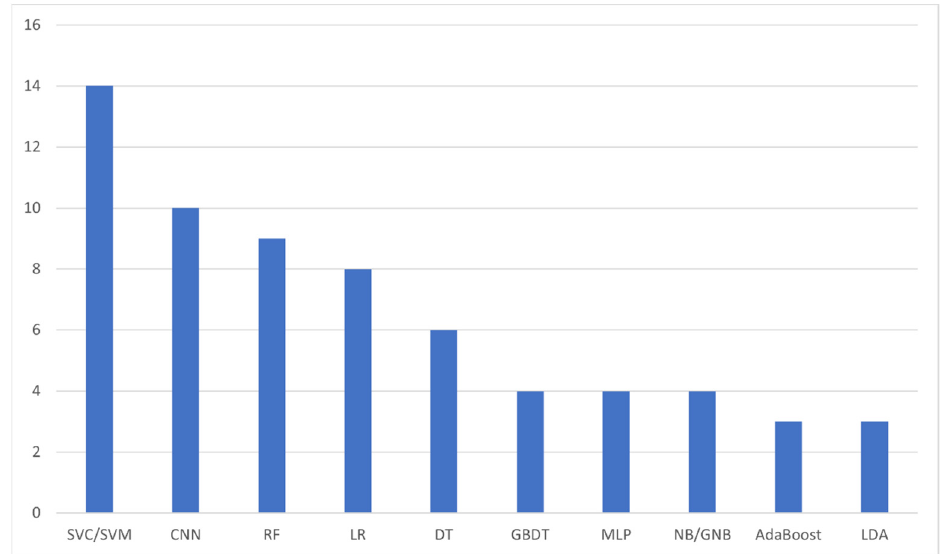
Figure 6. The most frequently appearing artificial intelligence algorithms within the included studies. SVC: Supporting Vector Classification; SVM: Supporting Vector Machine; CNN: SVC: Supporting Vector Classification; SVM: Supporting Vector Machine; CNN: Convolutional Convolutional Neural Network; RF: Random Forest; LR: Logistic Regression; DT: Decision Tree; Neural Network; RF: Random Forest; LR: Logistic Regression; DT: Decision Tree; GBDT: Gradient GBDT: Gradient Boosting Decision Tree; MLP: Multi-Layer Perceptron; NB/GNB: (Gaussian) Naïve Boosting Decision Tree; MLP: Multi-Layer Perceptron; NB/GNB: (Gaussian) Naïve Bayes; LDA: Bayes; LDA: Linear Discriminant Analysis. Linear Discriminant